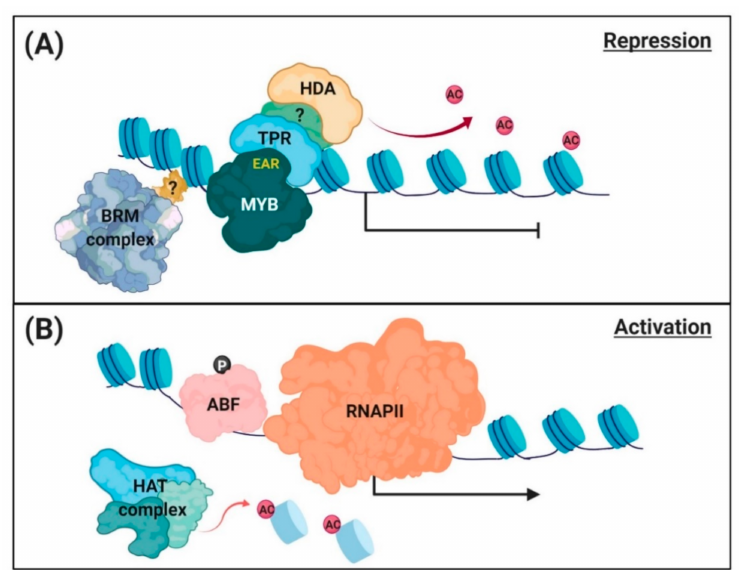
Figure 2. A working model of chromatin remodeling for regulation of PP2C gene transcription. ( A ) Repression of PP2C gene transcription. Under normal conditions, enhancer of ABA coreceptor (EAR) motif-containing MYB repressors (AtMYB44 and AtMYB20) interact with a TOPLESS-related corepressor (TPR), which recruits histone deacetylase (HDA) to suppress PP2C gene